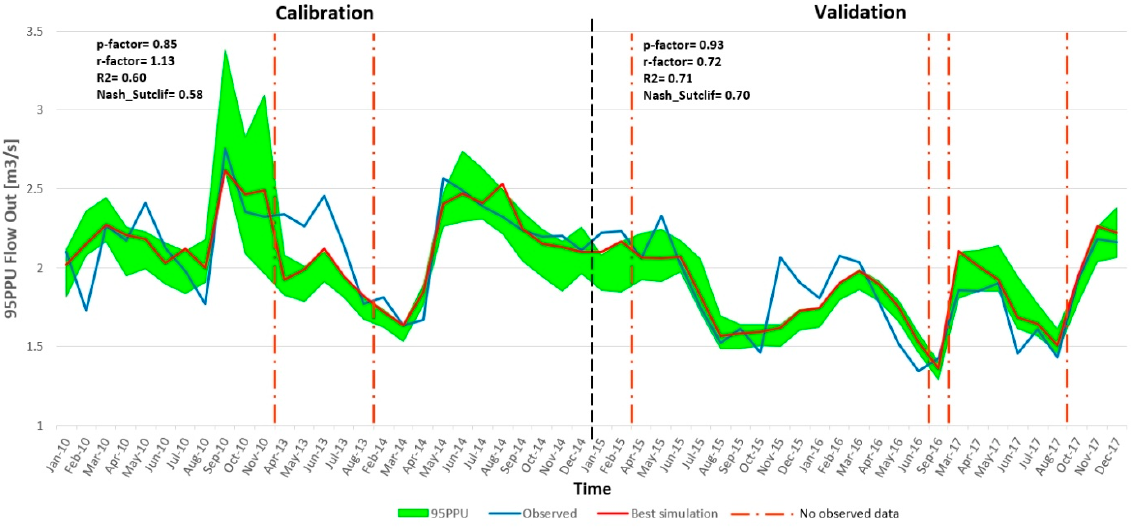
Figure 7. 95ppu plot and observed streamflow during calibration and validation (own study).